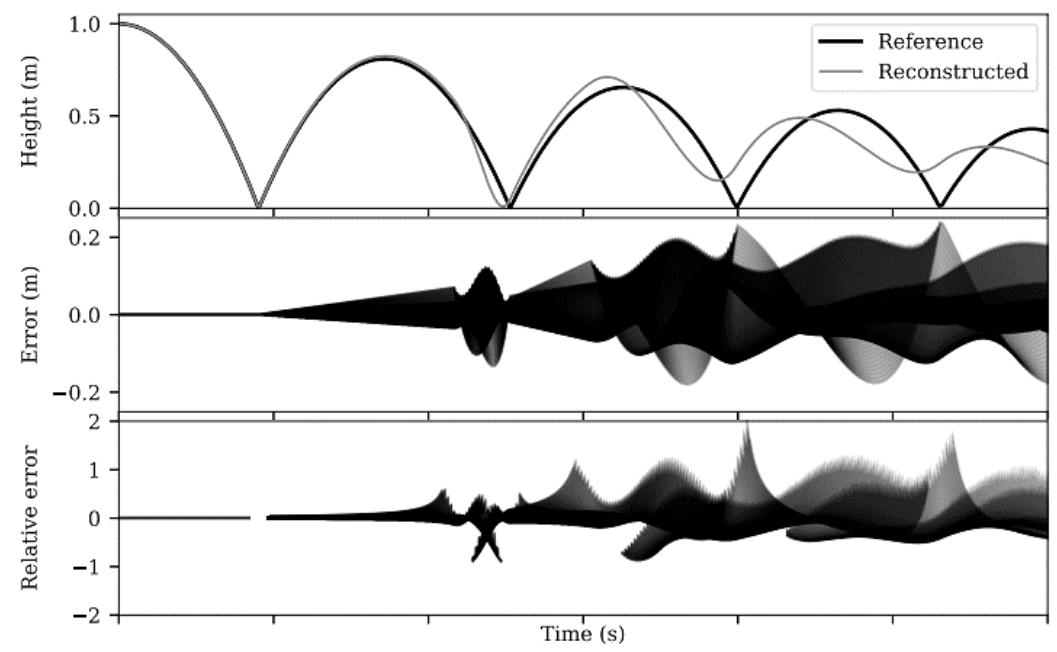
Figure 2. Reconstruction performance of PCA with a single principal component when only the coefficient of restitution varies. Top: comparison between original and reconstructed trajectories producing the worst RMSE. Middle: absolute reconstruction errors. Bottom: relative reconstruction errors. Intervals where the height was below 0.1 m were discarded. Lines are set to 0.1opacity; darker tint indicate superposition of many